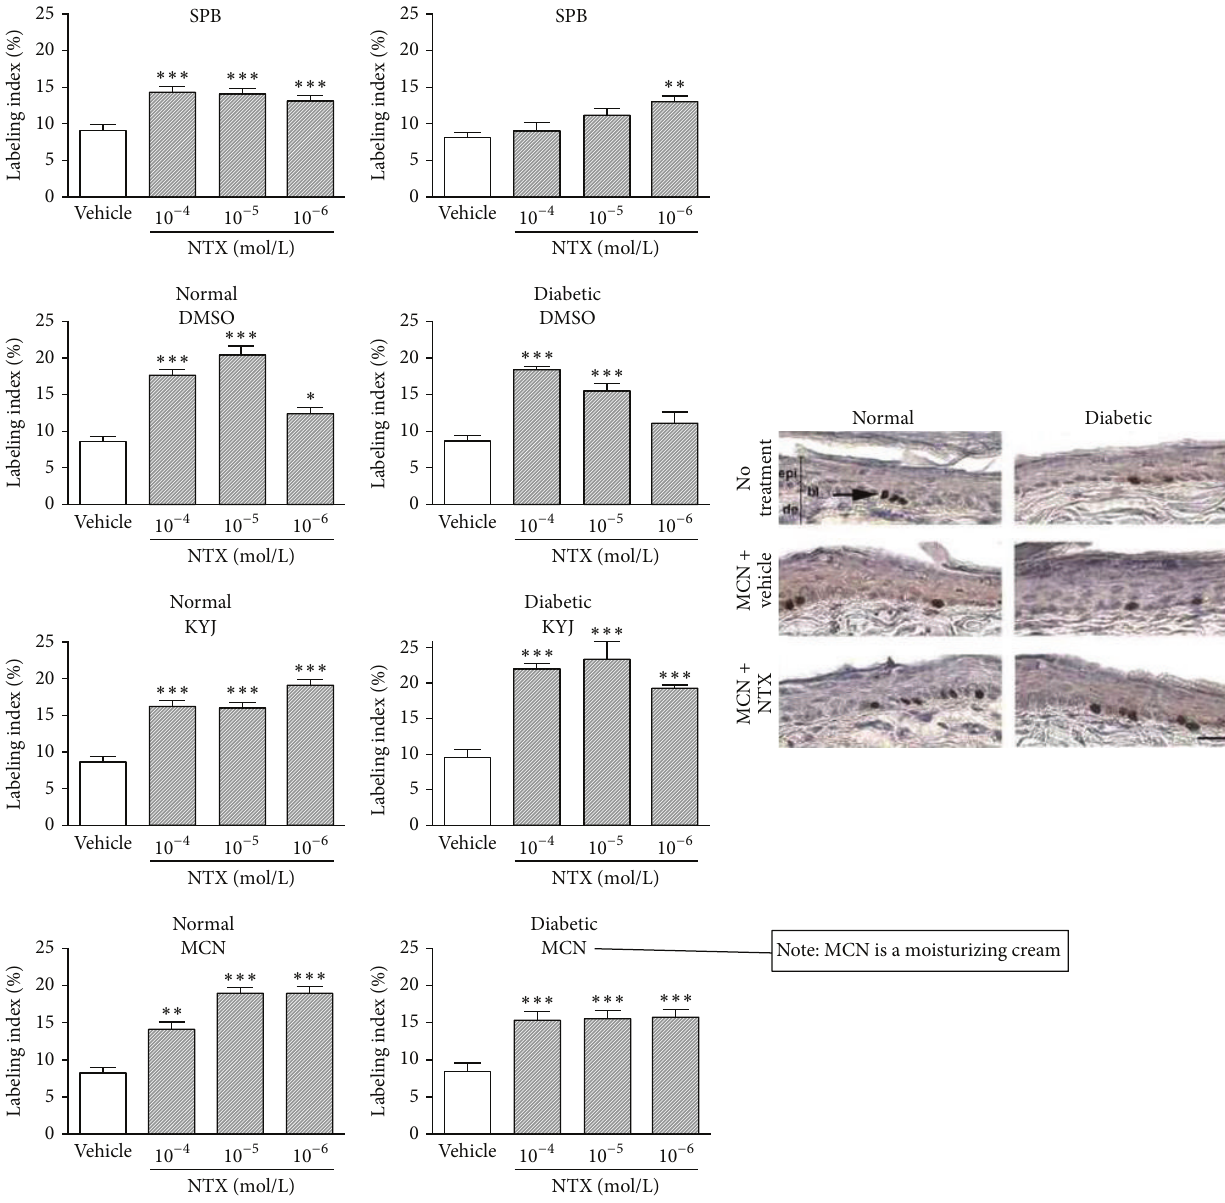
Figure 17: Effect of topical NTX in various vehicles on labeling index (LI) of skin epithelium. NTX was applied topically to the skin in type 1 diabetic rats or normal rats using NTX 10 −4 M, NTX 10 −5 M, or NTX 10 −6 M in Sorenson’s phosphate buffer, lubricant, moisturizing cream, or dimethylsulfoxide. NTX applied TID topically to dorsal skin of normal rats elevated LI by 43% to 132% in any of the four vehicles compared to normal baseline. NTX applied TID topically to dorsal skin of DB rats elevated LI by 103–147% in lubricant and by 85–89% in moisturizing cream. Photomicrographs demonstrate relative frequency of DNA synthesizing cells containing label. SPB: buffered